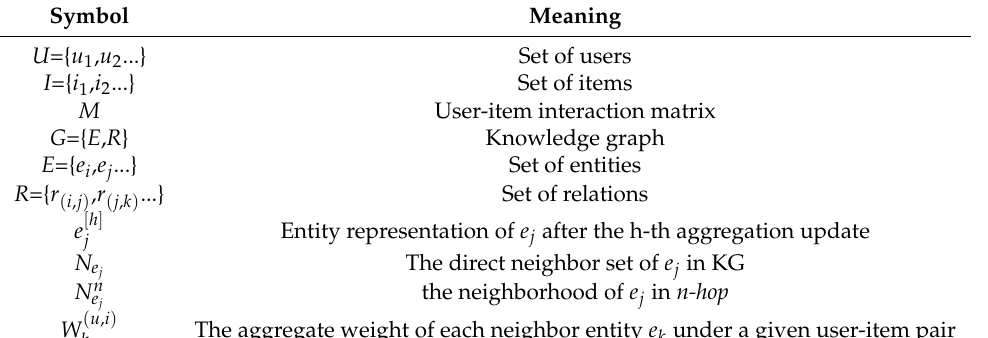
Table 1. List of key